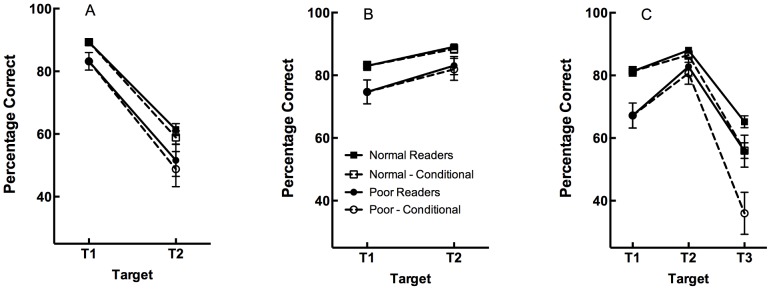
Mean target accuracy in TDT (Panel A), TT (Panel B), and TTT (Panel C) conditions.Dashed lines and open symbols represent conditional target accuracy, while solid symbols and lines represent unconditional target accuracy. Error bars represent one standard error of the mean.